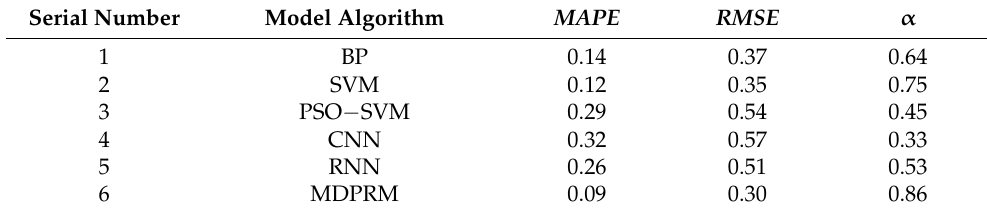
Table 2. Evaluation of simulation accuracy of different model